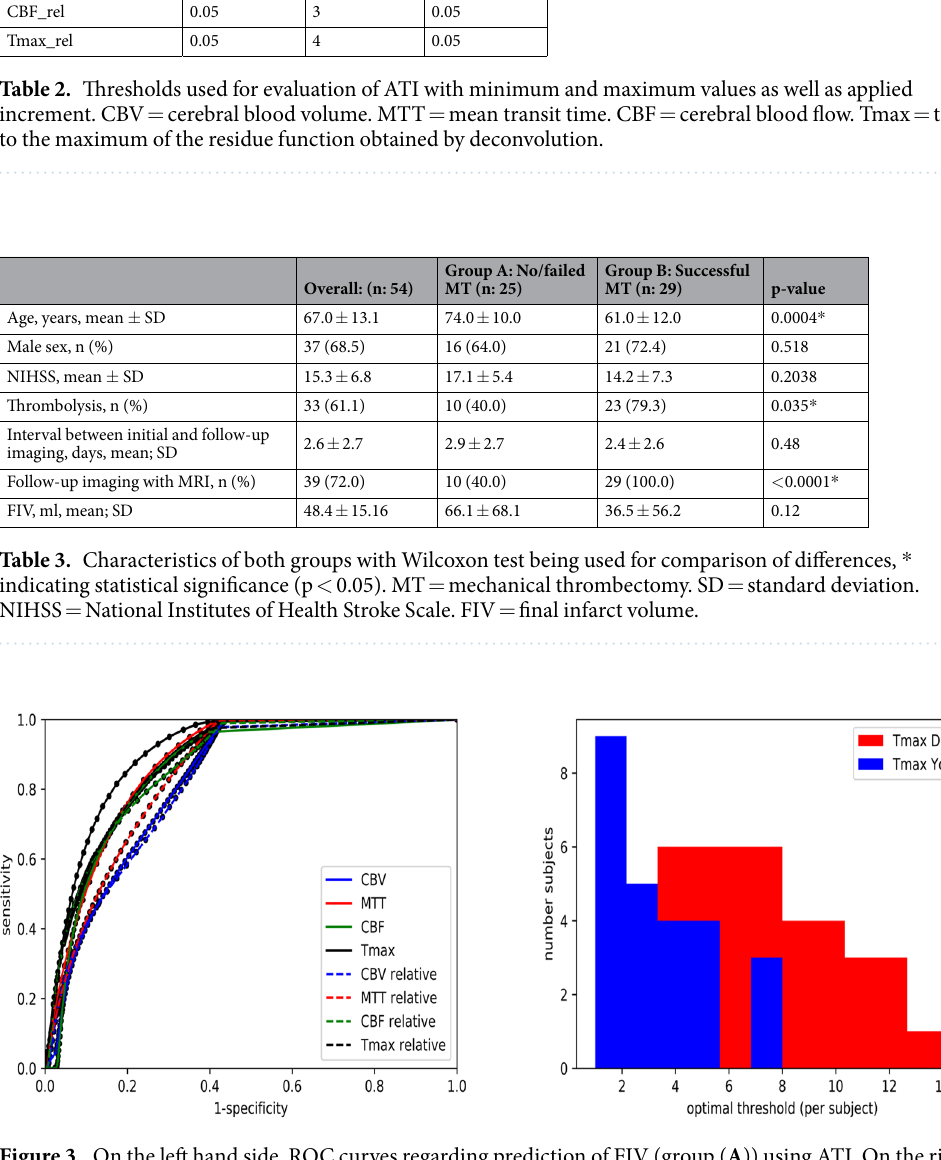
Figure 3. On the left hand side, ROC curves regarding prediction of FIV (group ( A )) using ATI. On the right hand side, optimal threshold distribution per subject in seconds regarding Tmax of ATI using Dice’s coefficient and Youden-Index. CBV = cerebral blood volume. MTT = mean transit time. CBF = cerebral blood flow. Tmax = time to the maximum of the residue function obtained by